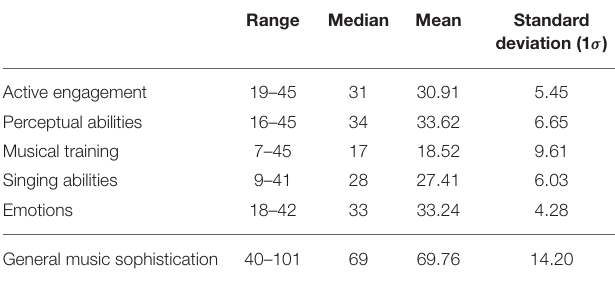
TABLE 1 | Prolific participant demographics. TABLE 2 | GMSI range, median, mean, and standard